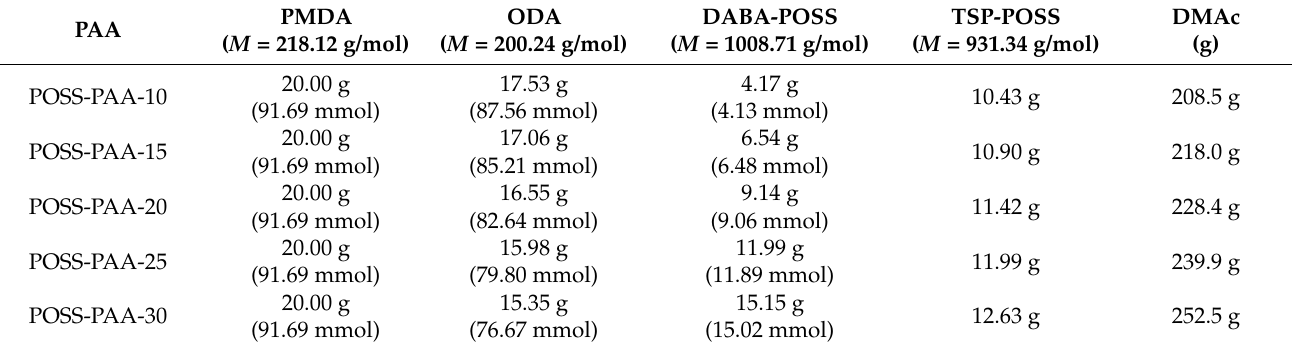
Figure 3. Preparation procedure of POSS-PI films. Table 1. Formulation for the synthesis of POSS-PAAs.